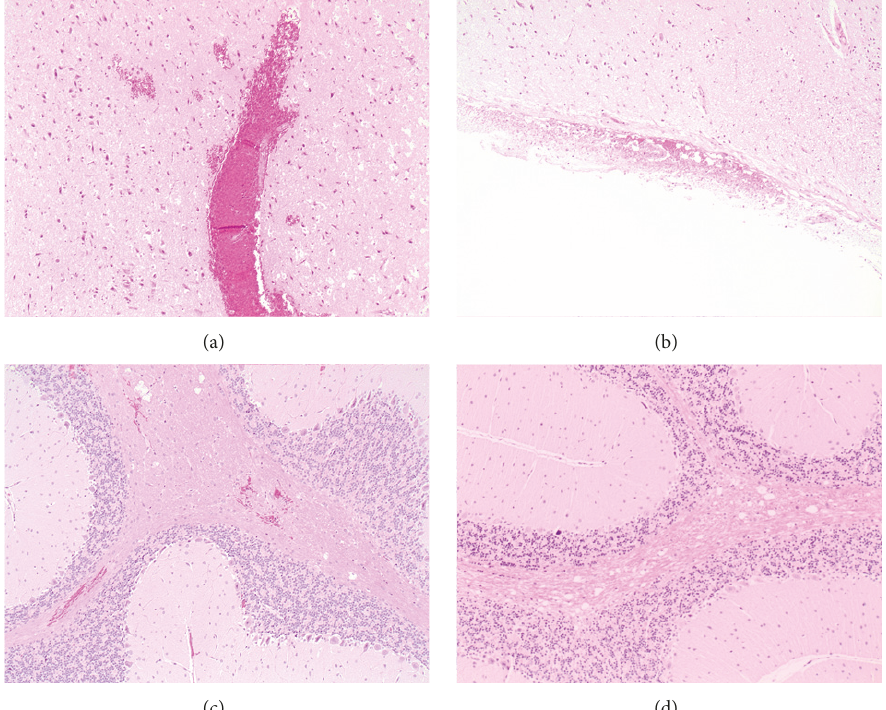
Figure 1: Histologic findings in the brain in rats treated with brodifacoum . (a) Vascular congestion, perivascular and interstitial hemorrhage, anterior brain, × 100. (b) Subarachnoidal hemorrhage, posterior brain, × 100. (c) Interstitial hemorrhage, cerebellum, × 100. (d) Control rat, cerebellum, × 100.